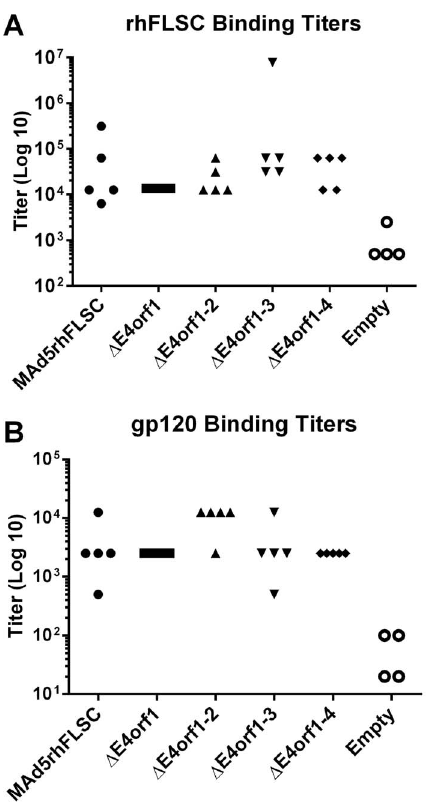
Figure 9. Deletion of E4orf1 through E4orf4 has little to no effect on antibody binding or specificity. ( A–B ) Sera collected from vaccinated mice were tested for specific binding to rhFLSC or HIV BaL gp120 proteins by ELISA. Log base 10 titers for each mouse were plotted and differences in comparison to titers obtained using sera from the control empty vector mice were analyzed. No differences were observed between the parent and the E4 -deleted viruses (p . 0.05). The binding titers of the combined vaccinated groups were significantly different from those of the empty vector group (p ,